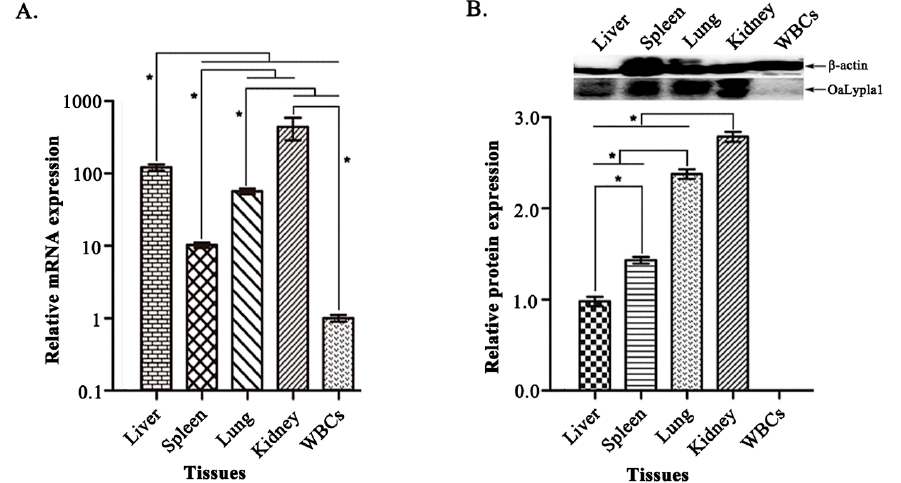
Figure 7. Tissue distribution of OaLypla1 . ( A ) The tissue distribution of OaLypla1 determined by quantitative real-time PCR. The mRNA levels in tissues were normalized with β -actin ; ( B ) OaLypla1 protein detected in the tissues using Western blotting. Statistical differences among liver, spleen, lung, kidney, and white blood cells were determined by one-way analysis of variance (ANOVA) using SPSS 13.0 software (IBM, Armonk, NY, USA). Data are presented as the mean relative expression ± SD ( n = 3). An asterisk indicates a statistically significant difference (* p < 0.05). WBCs: white blood cells. Table 1. Primers used in this